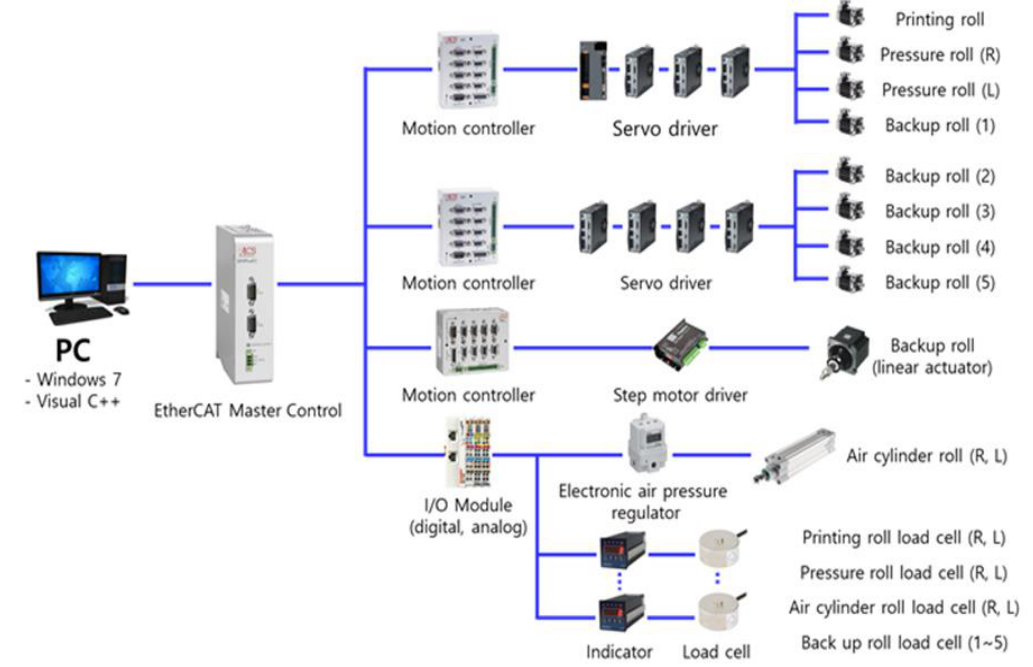
Figure 6. Configuration of the control system for large-area R2R uniform pressing system.